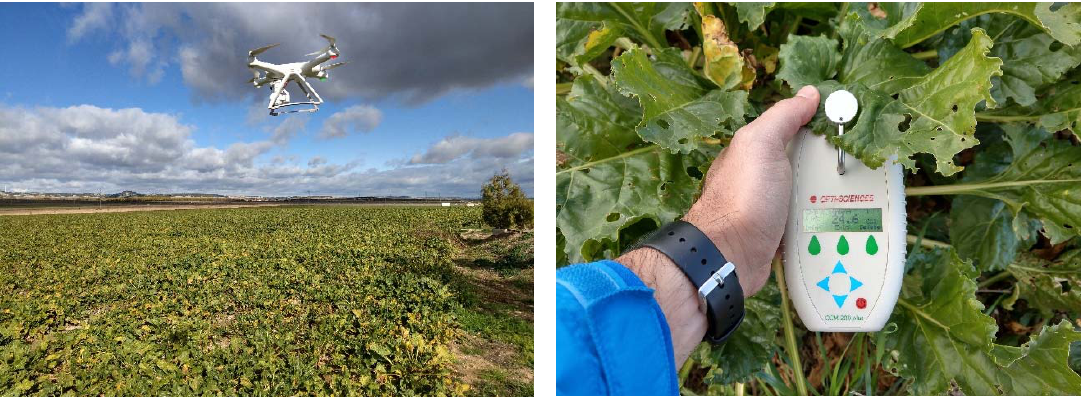
Figure 3. ( Left ) Unmanned aerial vehicle used for field data collection; ( right ) measurement with CCM ‐ 200 chlorophyll meter.